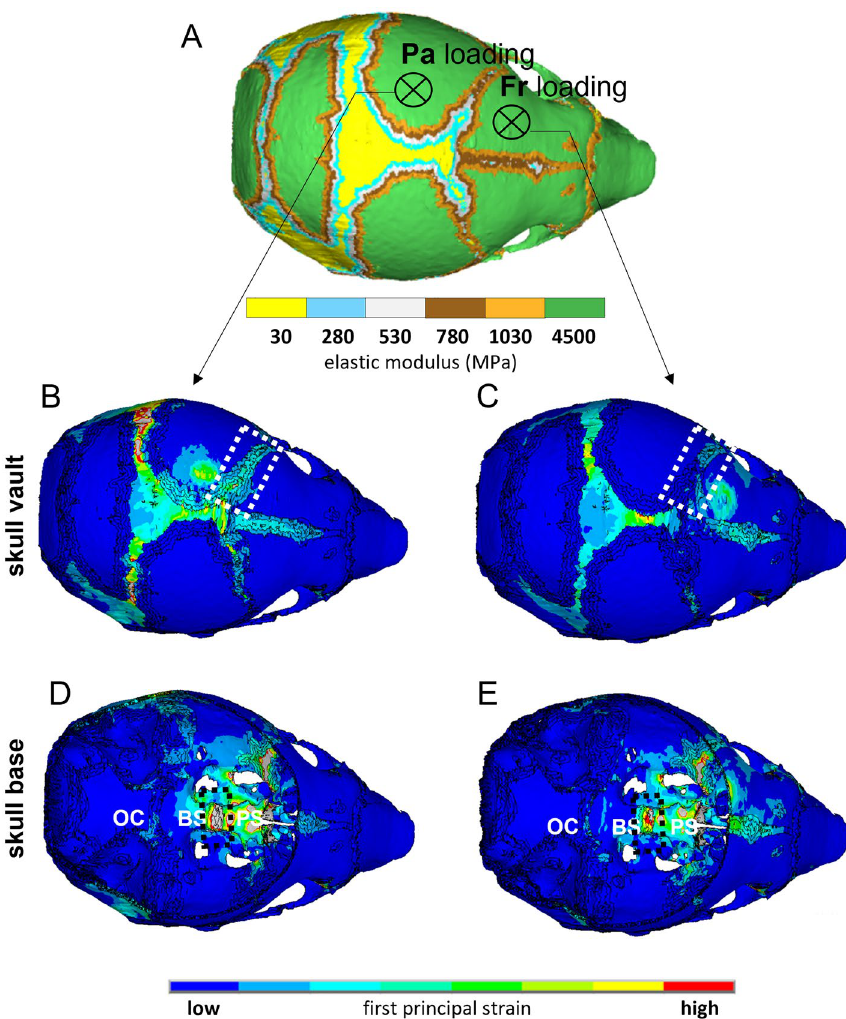
Figure 5. Comparing the pattern of mechanical strain distribution across the skull between frontal and parietal loading. ( A ) Finite element model of a P3 mouse skull that was computationally grown to P7 and used to investigate the difference in the pattern of strain distribution due to the frontal and parietal loading. It indicates the mechanical properties of different skull regions and the anatomical position that were loaded analogous to the in vivo experiments. Heat maps were generated using ANSYS v.18 (ANSYS Inc., Canonsburg, PA, USA). ( B , C ) Comparing the pattern of first principal strain across the skull roof between parietal and frontal loading respectively. The dashed box highlights the coronal suture. ( D , E ) Comparing the pattern of first principal strain across the skull base between parietal and frontal loading respectively. The dashed box highlights the ISS (intersphenoidal synchondrosis). OC occipital, BS basi-sphenoid, PS